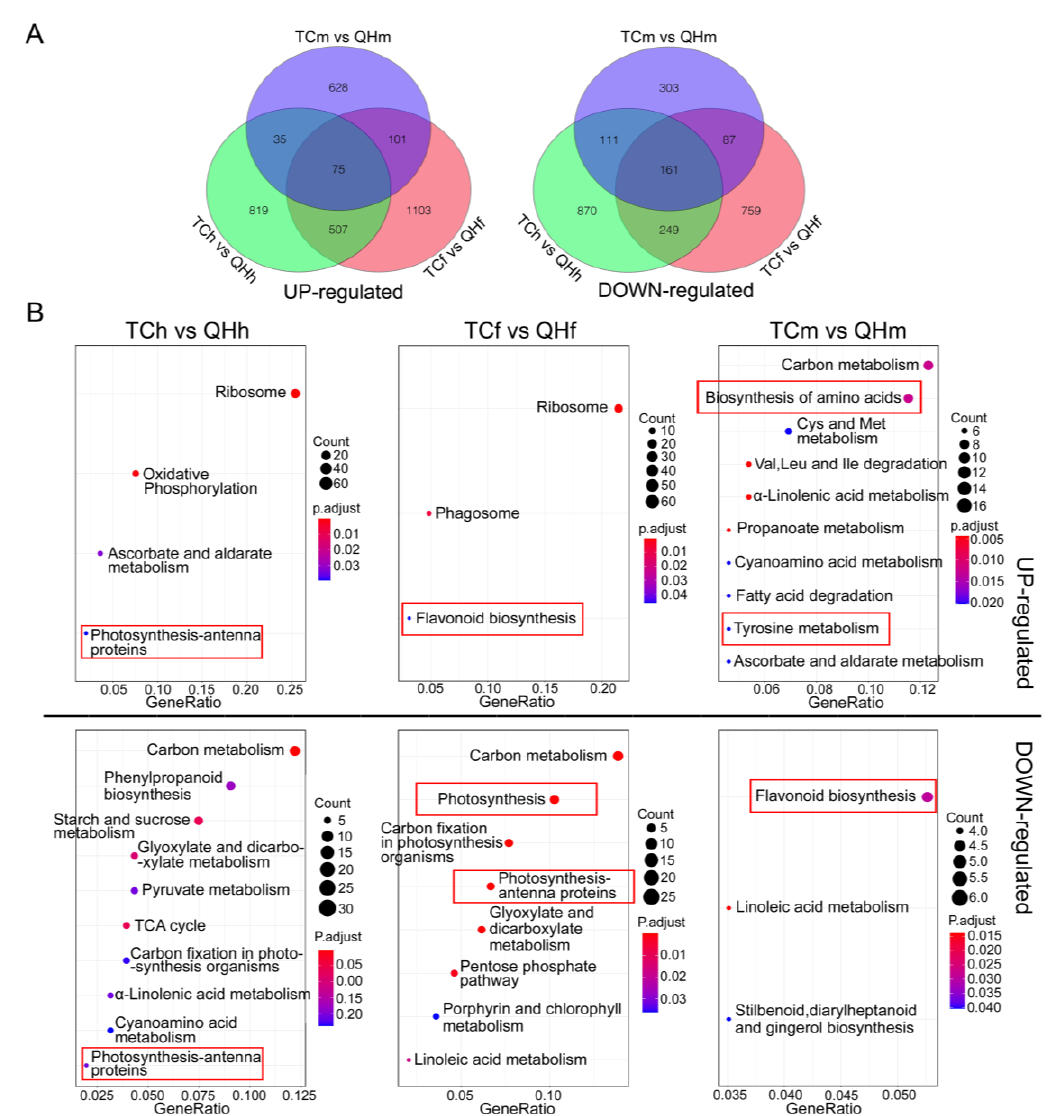
Figure 4. The enrichments of DEGs during oat bract development. ( A ) Venn diagrams of upregulated and downregulated DEGs in ‘Qinghai 444’, compared to those in ‘Triple Crown’. ( B ) KEGG enrichment of upregulated and downregulated DEGs in ‘Qinghai 444’, compared to those in ‘Triple Crown’. Red square line represents the pathways which are related to photosynthesis and anthocyanin or melanin biosynthesis in this study.